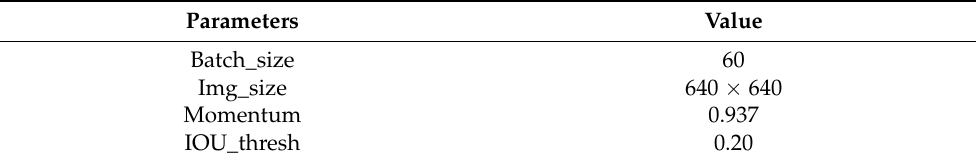
Table 2. Relevant training